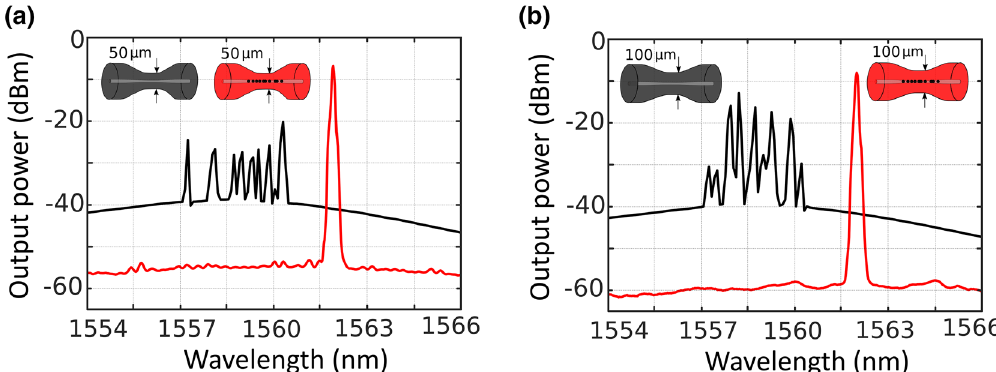
Figure 9. ( a ) Output spectra of the short-linear-cavity fiber laser, pumped by a 1480-nm light at 500 mW and using an un-drilled (black line) or a micro-drilled (red line) 50 µm-waist tapered fiber. ( b ) Output spectra of the short-linear-cavity fiber laser, pumped by a 1480-nm light at 500 mW and using an un-drilled (black line) or a micro-drilled (red line) 100 µm-waist tapered fiber.